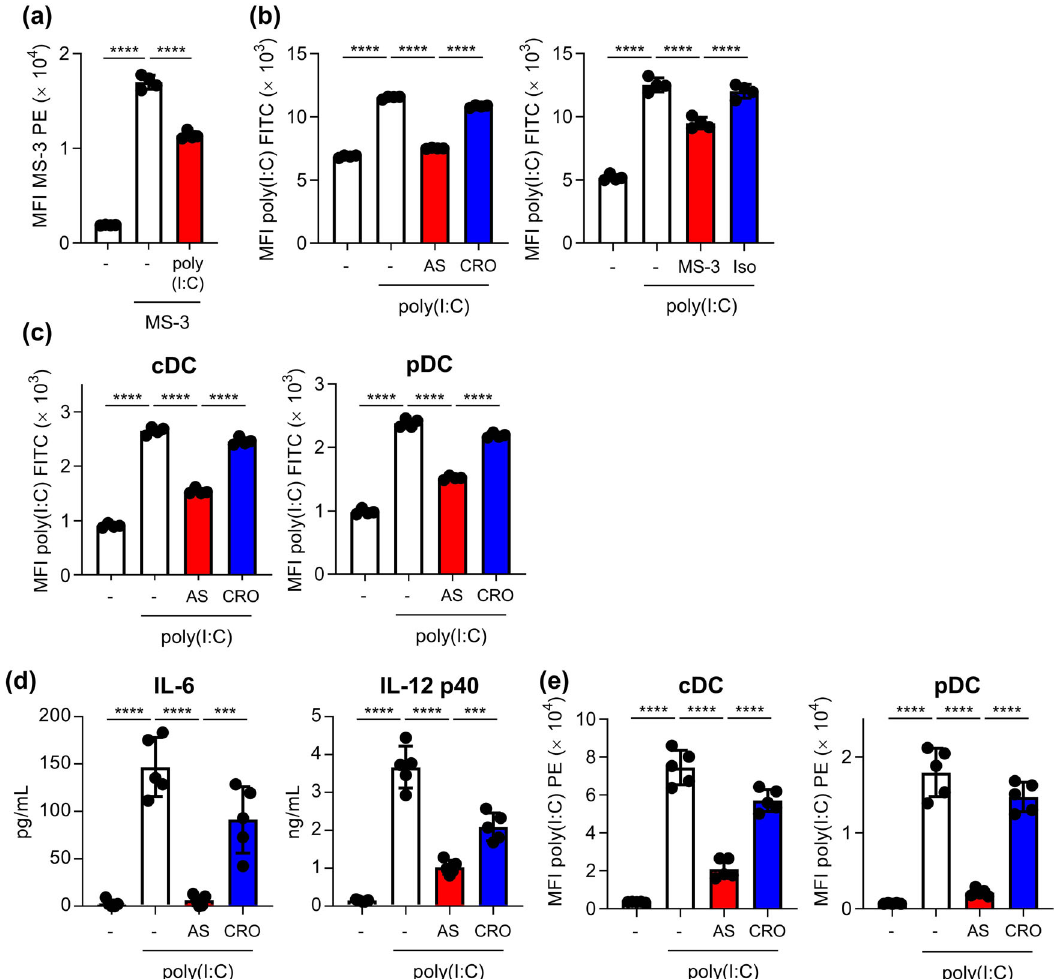
Fig. 5 Nucleolin-dependent internalization into DCs and immune responses on DCs of poly(I:C). a DC2.4 cells were treated with 10 μ g/mL PE-labeled MS-3 with or without 50 μ g/mL poly(I:C) at 4 °C for 1 h. The binding of MS-3 on the cell surface of DC2.4 cells was analyzed by fl ow cytometry. b DC2.4 cells were treated with 5 μ g/mL FITC-labeled poly(I:C) with or without 5 μ M AS1411, 5 μ M CRO, 50 μ g/mL MS-3, or 50 μ g/mL isotype control antibody at 37 °C for 30 min. Internalization of FITC-labeled poly(I:C) into DC2.4 cells was measured by fl ow cytometry after trypan blue quenching. c Mouse-derived BMDCs were treated with 5 μ g/mL FITC-labeled poly(I:C) with or without 5 μ M AS1411 or 5 μ M CRO at 37 °C for 30 min. Internalization of FITC-labeled poly(I:C) into BMDCs was measured by fl ow cytometry. d , e BMDCs were treated with 1 μ g/mL poly(I:C) with or without 5 μ M AS1411 or 5 μ M CRO at 37 °C for 24 h. d The concentrations of IL-6 and IL-12 p40 in the supernatants were then measured by ELISA. e The expression levels of CD86 on cDCs and pDCs were measured by fl ow cytometry. a – e Each experiment was performed more than twice. Data are shown as the means ± SD. * P < 0.05, *** P < 0.001, **** P < 0.0001 by Tukey ’ s